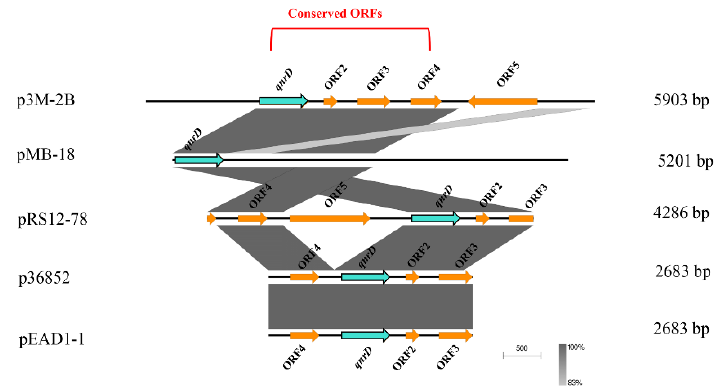
Figure 4. Linear comparison of p3M-2B with other closely related qnrD -carrying plasmids isolated from P. vulgaris strains.